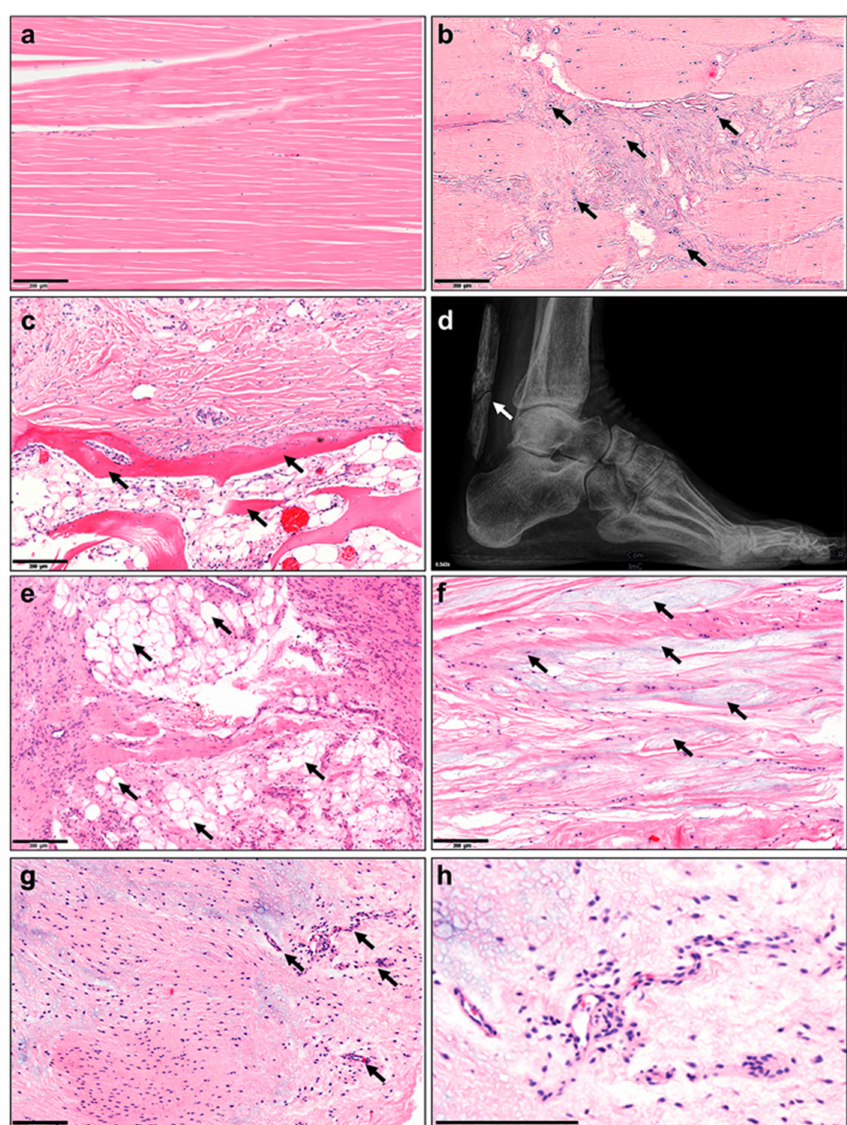
Figure 2. Tendinopathy-related histopathological characteristics in human tendon tissue. Hematoxylin–eosin staining of ( a ) normal tendon tissue and abnormalities such as the ( b ) presence of chondrocytes, ( c ) ossification, (d) calcification of the Achilles tendon (X-ray image), ( e ) accumulation of adipocytes, ( f ) myxoid (or mucoid) degeneration and ( g ) hypervascularization. ( h ) Image g) 10 x zoomed in. Scale bars: 200 µ m. Arrows indicate the corresponding feature per image. Images derived from the histopathological archive of Prof. Christoph Brochhausen, Institute of Pathology, University